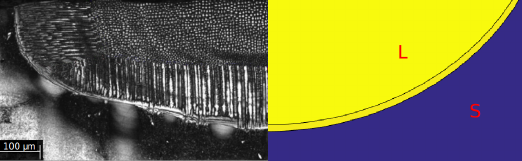
Figure 4. Comparison of experimental and calculated melt pools for the CMSX-4 (cid:114) Specimen A of Wang et al [36] (Reproduced from [36], with permission of Elsevier, 2017.). L corresponds to the liquid zone of the melt pool and s corresponds to the solid substrate.